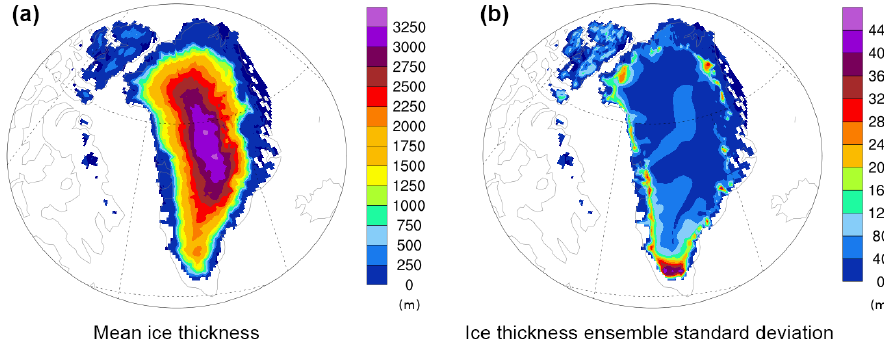
Figure 11. Greenland ice thickness ensemble (a) mean, and (b) standard deviation at PD.